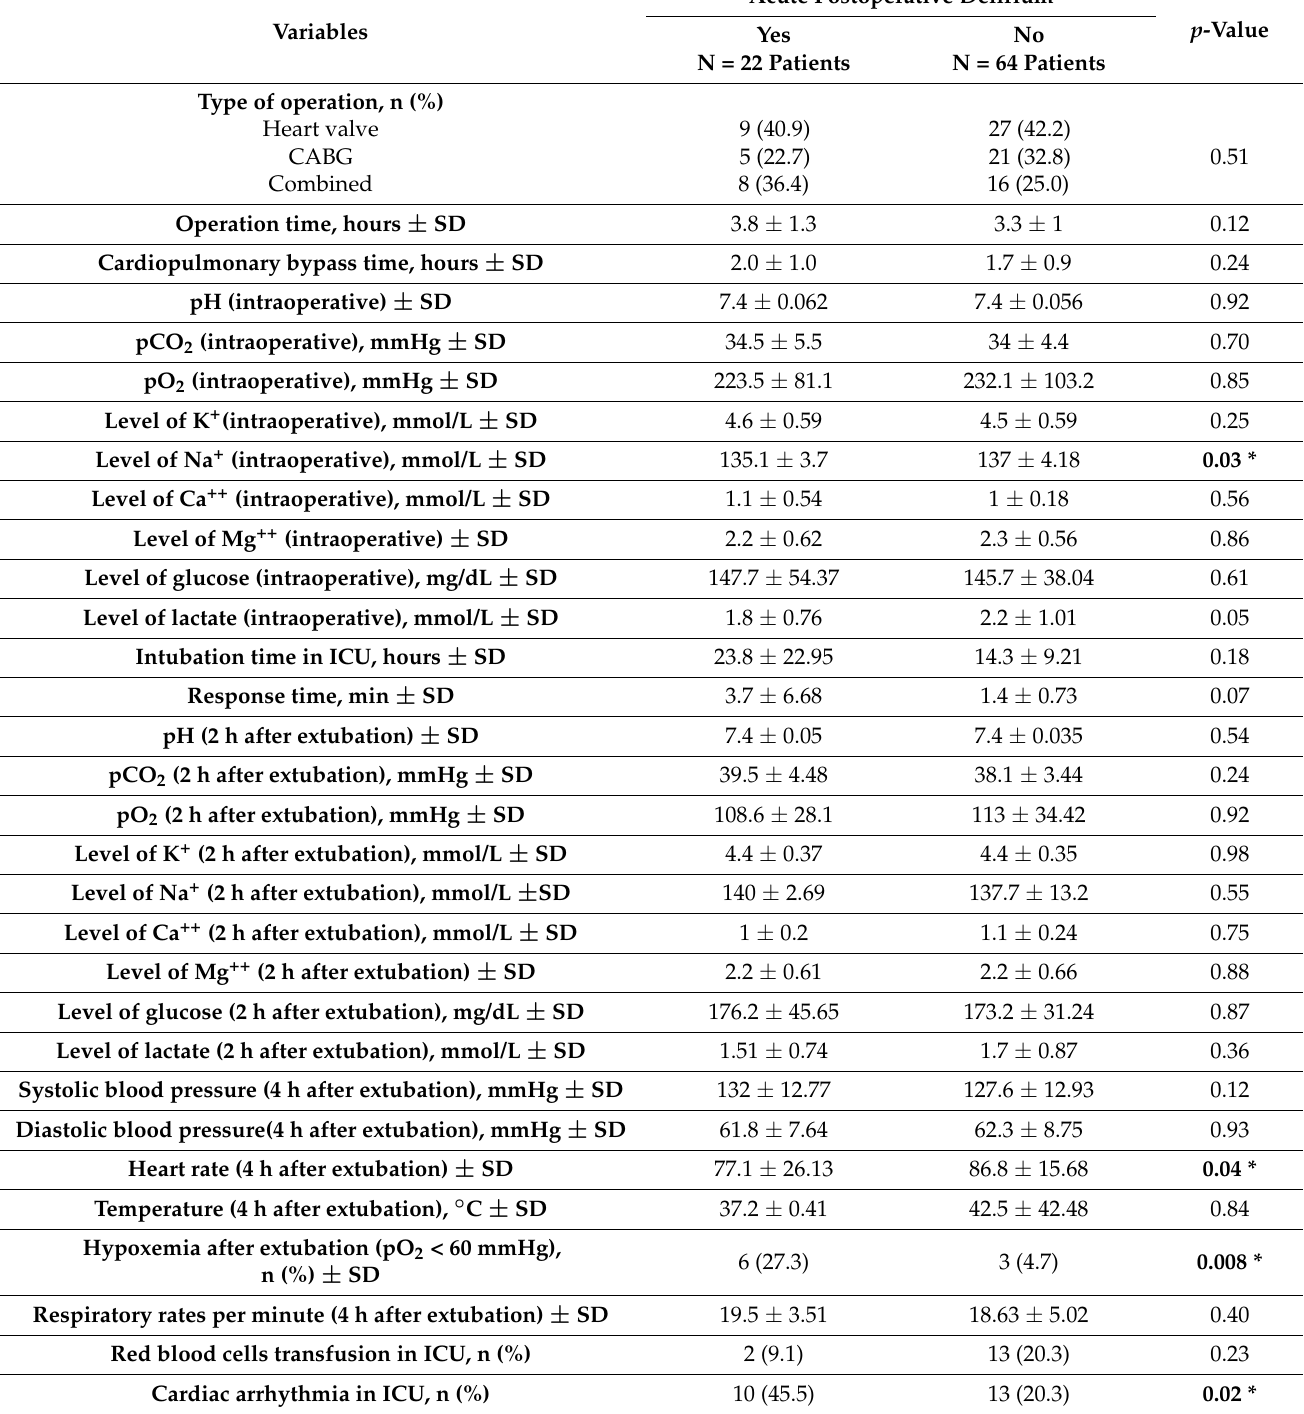
Table 4. Comparison of perioperative details between two groups with and without acute